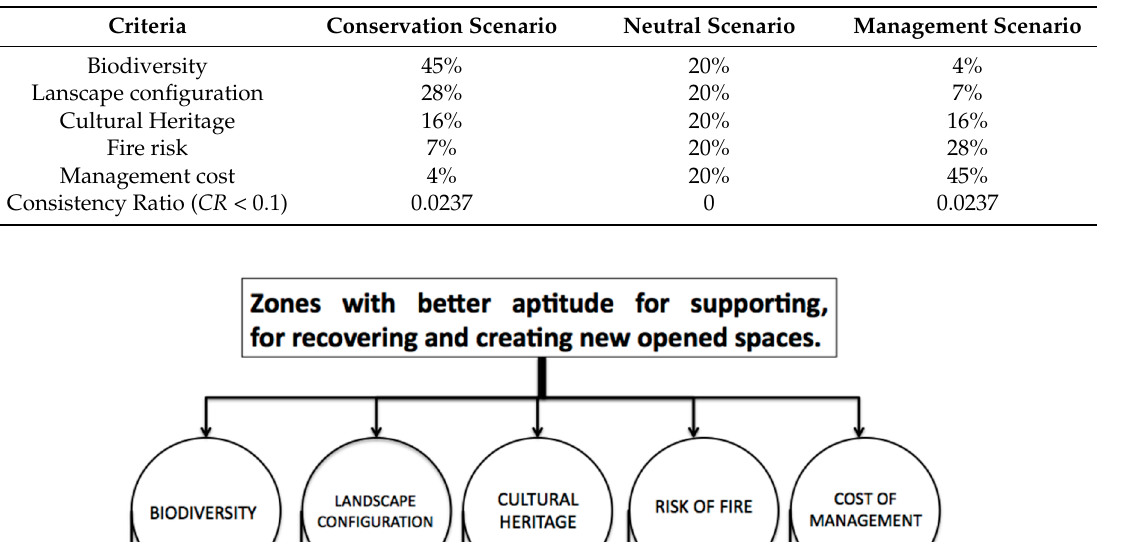
Table 3. Weights and criteria developed for local stakeholders for agrarian land recovery.